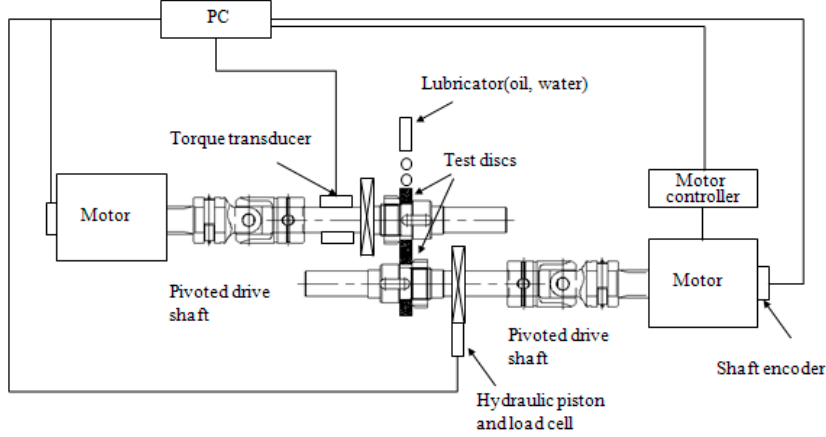
Figure 13. Schematic diagram of the twin ‐ disc test machine.